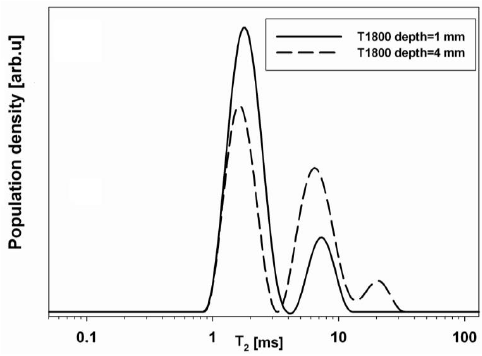
Figure 8. T 2 relaxation time distributions in sandstone treated with DMS for 1800 s (T1800) at a depth of 1 mm (solid line), and 4 mm (dashed line). Adapted from [50]. Copyright Spriger Nature, 2011.